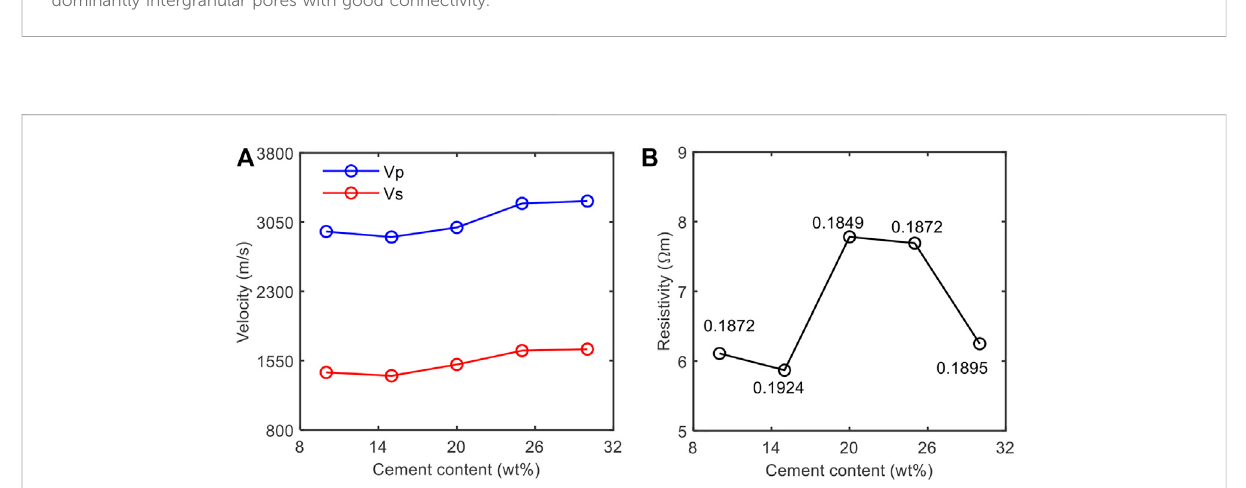
Typical thin section images of the samples with same cement content but with different porosity. Images (A) and (B) are respectively corresponding to the samples with porosity of 15.19% and 17.19%, and show that the majority of the pores are residual intergranular pores with poor connectivity. Images (C) , (D) , and (E) are for the samples with porosity of 19.12%, 20.02%, and 22.18%, respectively, illustrating the pores are dominantly intergranular pores with good